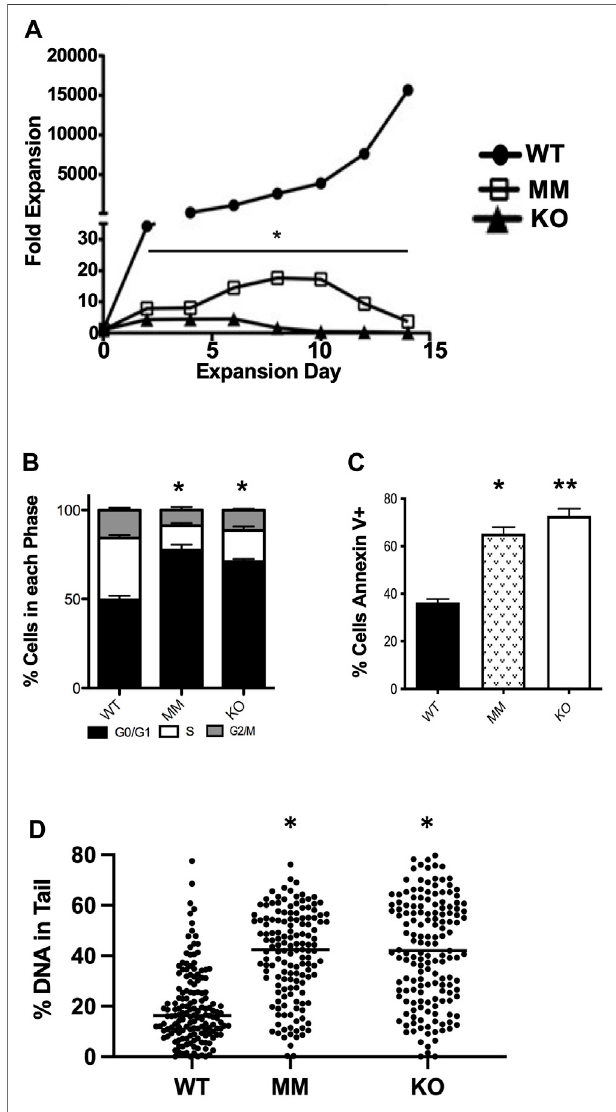
FIGURE 2 | Dot1L -KO and Dot1L -MM ESREs display defective proliferation and survival. Cells isolated from E10.5 wildtype (WT), Dot1L -KO, and Dot1L -MM YSs were cultured in expansion media for ESREs. (A) Cell numbers were counted via trypan blue exclusion every 2 days for 14 days,andfoldexpansionwascalculatedrelativetoday3afterisolation.On day6 – 7ofcounting,cellswerelabeledwithpropidiumiodideorAnnexinVand analyzed via fl ow cytometry for cell cycle analysis (B) and apoptosis (C) . Alkaline Comet assays were performed on day 6 ESREs to assess DNA damage. Both Dot1L -KO and Dot1L -MM ESREs displayed evidence of increased DNA damage compared to WT, as measured by increased comet “ tail length ” . Solid lines indicate median percent DNA in comet tails (D) . (A,D) areimagesofrepresentativeexperiments, n ≥ 4. (B,C) arecompileddatafrom 4 separate experiments. In these fi gures, bars represent mean ± SE. *indicates p ≤ 0.05. **indicates p ≤